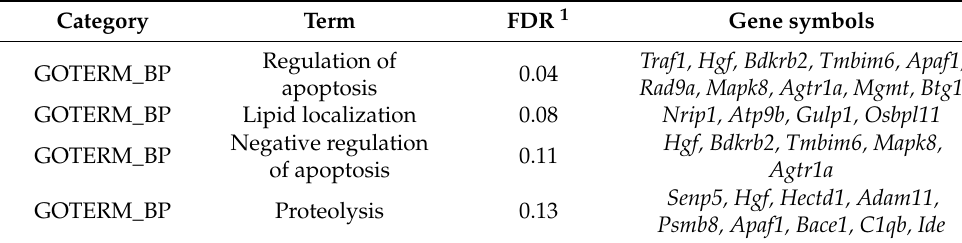
Table 8. Annotation clusters with significantly enriched GO biological processes and pathways for the top 30